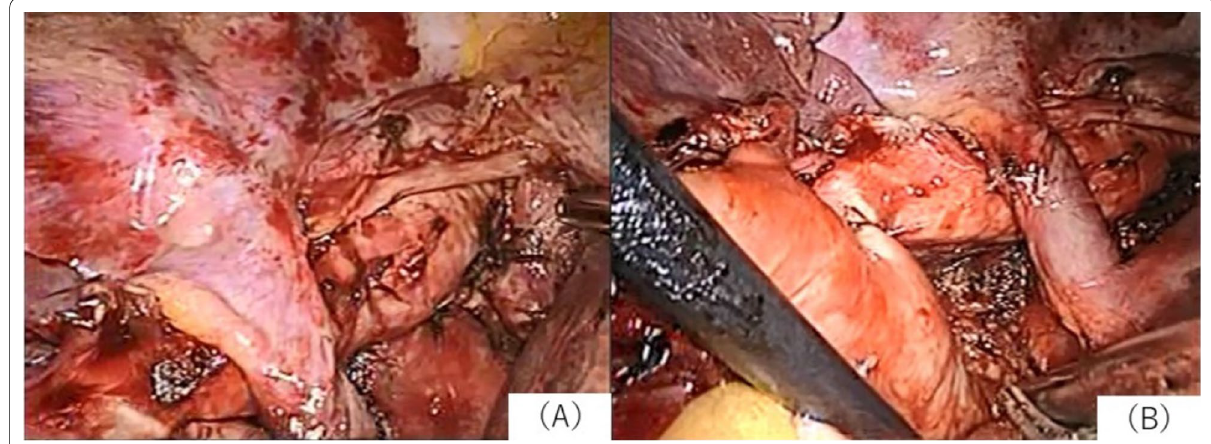
Fig. 2 Case 2: this figure shows the findings after the upper longitudinal node dissection. A is after the dissection of # 2R, and B is after the dissection of #